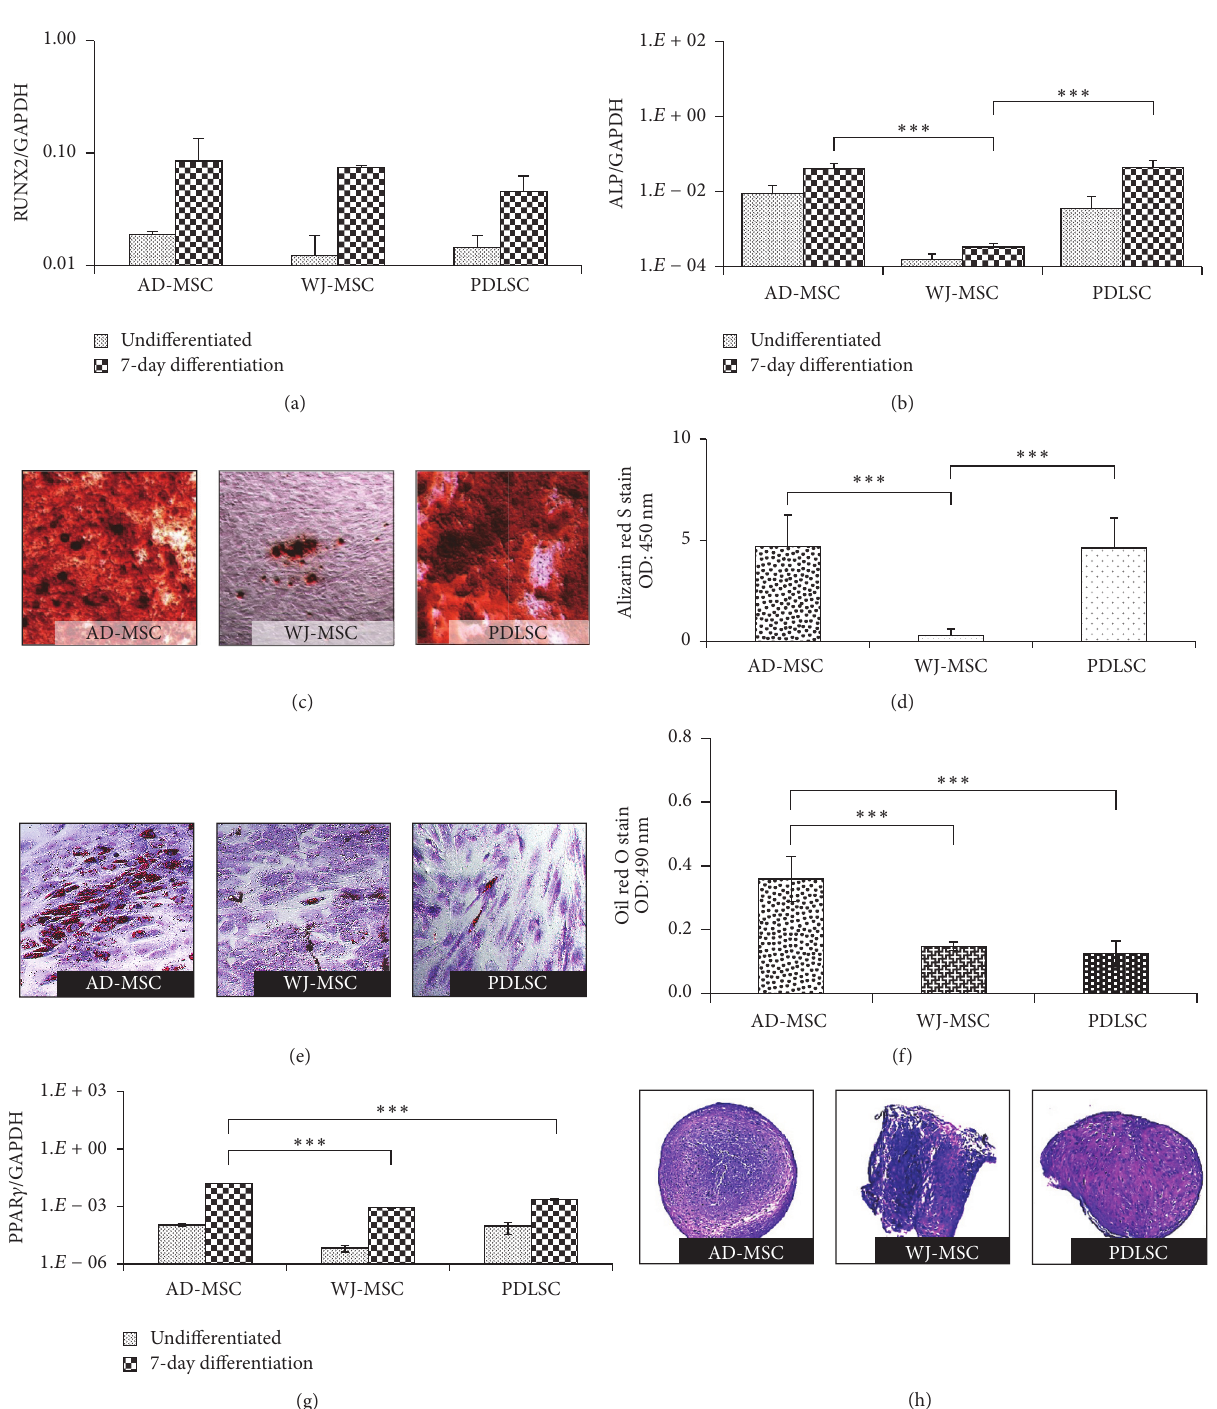
Figure3:ThetrilineagedifferentiationabilityofMSCisolates.TheexpressionleveloftheRUNX2(a)andALP(b)genesintheundifferentiated and differentiated samples, determined with RT-qPCR measurements. Alizarin red staining was used to demonstrate the calcium deposition of the matured bone matrix after 14 days of osteogenic induction (c). The stain was dissolved and quantified colorimetrically (d). Lipid accumulation was confirmed by oil red O staining (red dots) after adipogenic induction; cells were counterstained with dimethyl methylene blue stain (e). The concentration of the red stain was determined colorimetrically (f). The adipogenesis was followed with RT-qPCR measurement of PPAR 𝛾 gene (g). Chondrogenic differentiation was confirmed in all samples (h). The photos demonstrate representative samples. ∗∗∗ 𝑃 value less than